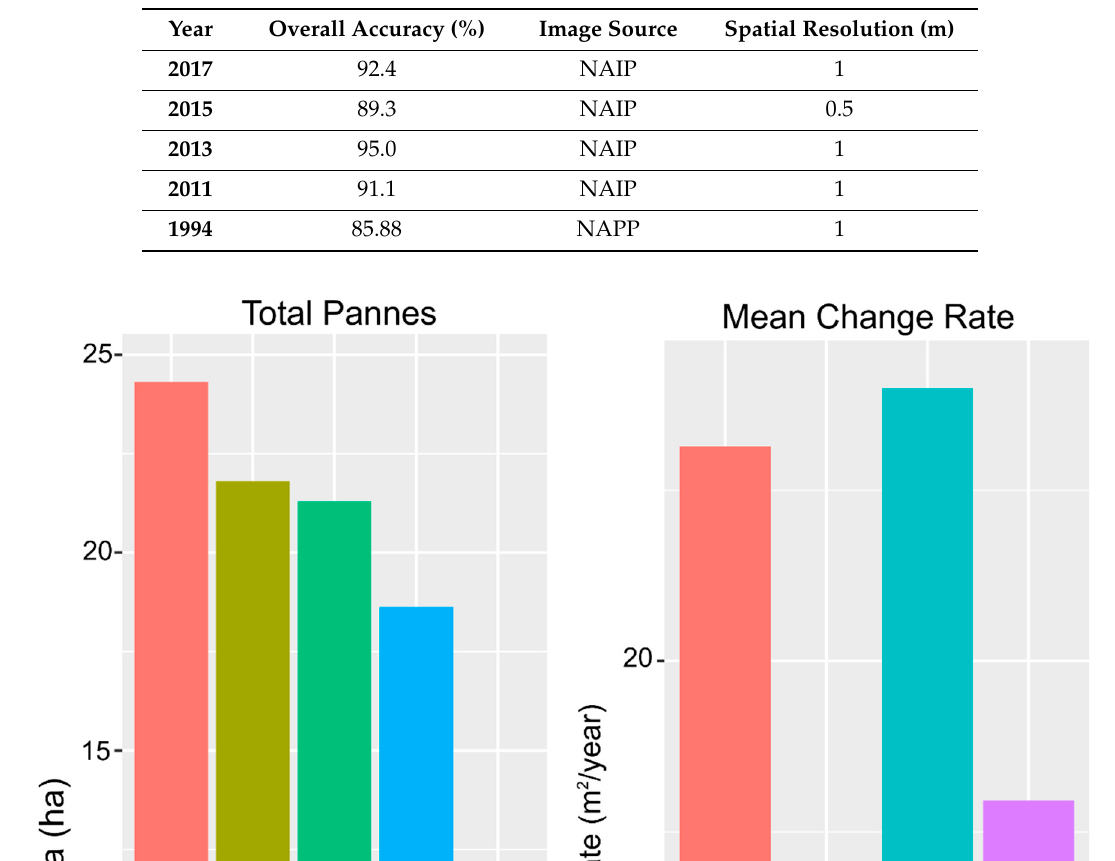
Table 3. Panne and edge overall classification accuracies, 1994–2015.